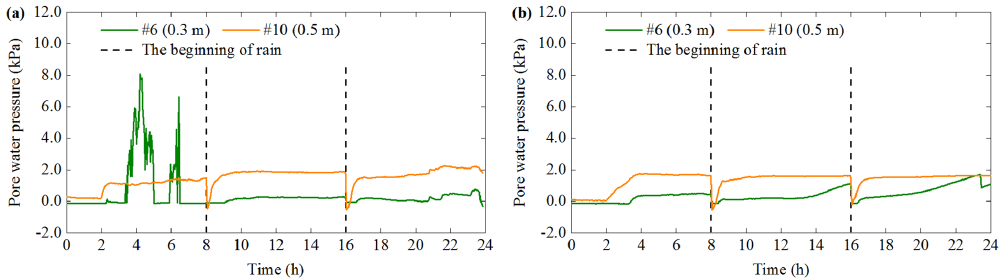
Figure 13. Pore water pressure at position C of (a) test 1 and (b) test 2.